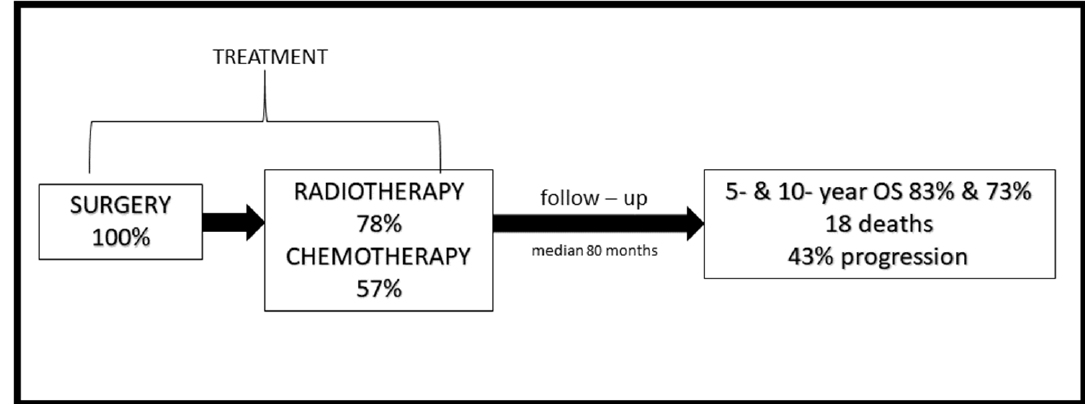
Figure A1. The schema of the study—treatment applied and outcome of the